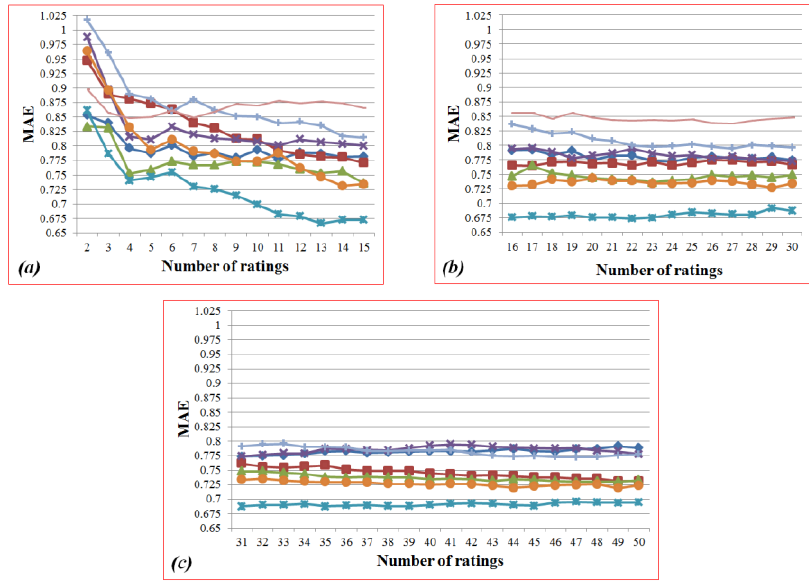
Figure 24. MAE values for the different numbers of ratings based on the cosine similarity in the user-based filtering.